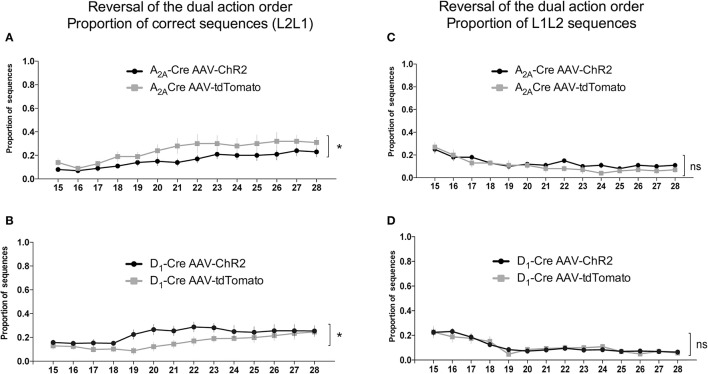
Antagonistic relationship between the indirect and direct pathway of the DLS on the proportion of correct sequences in the reversal of the dual action order. Photostimulation of iMSNs of the DLS decrease the proportion of correct sequences (L2L1) (A), while when the dMSNs of the DLS are photostimulated an increase in the correct sequence is observed (B). The quantification of the L1L2 (incorrect) indicate similar proportions when iMSNs (C) or dMSNs (D) are photostimulated. The data are mean ± SEM of n = 7–12 mice per group. *p < 0.05 when compared to the respective AAV-tdTomato control.